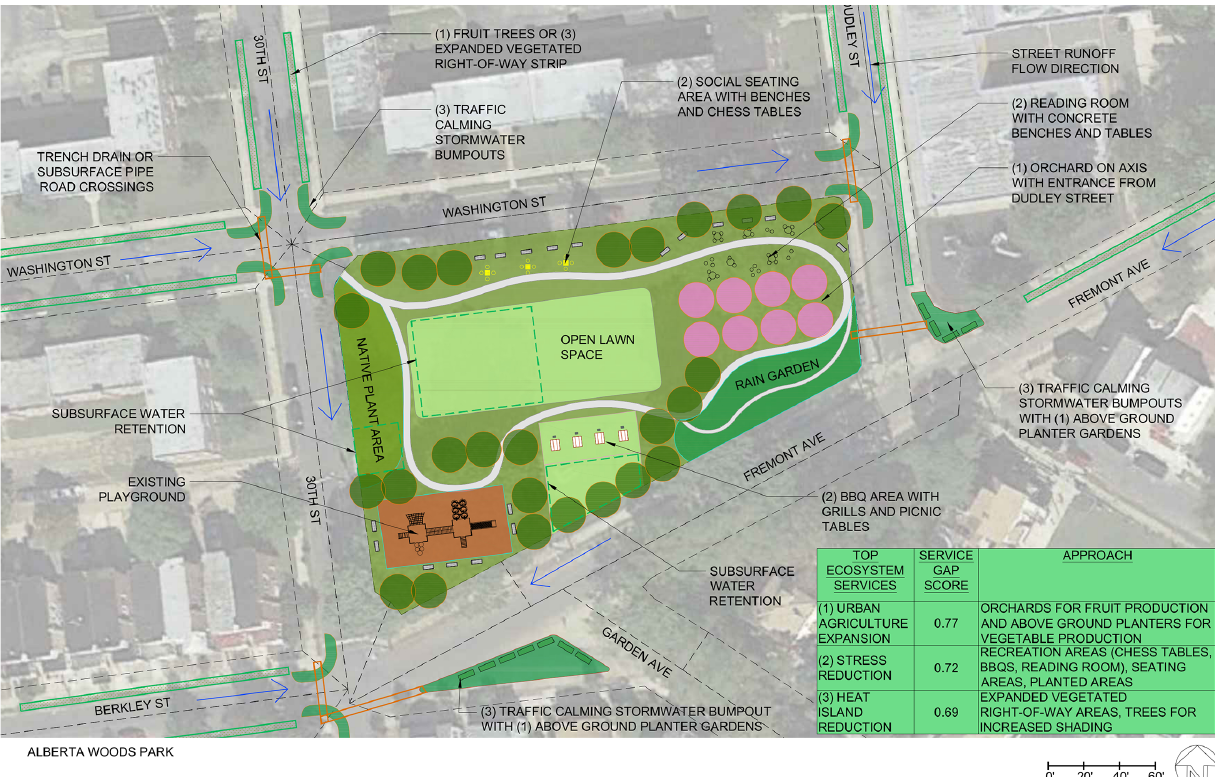
Figure 3. Alberta Woods Park concept